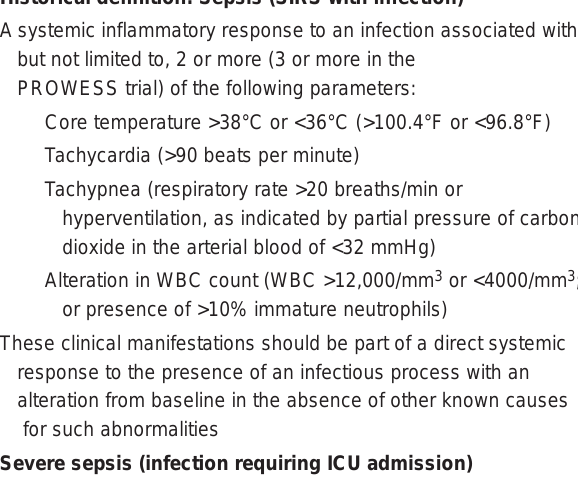
TABLE 2 Definitions of